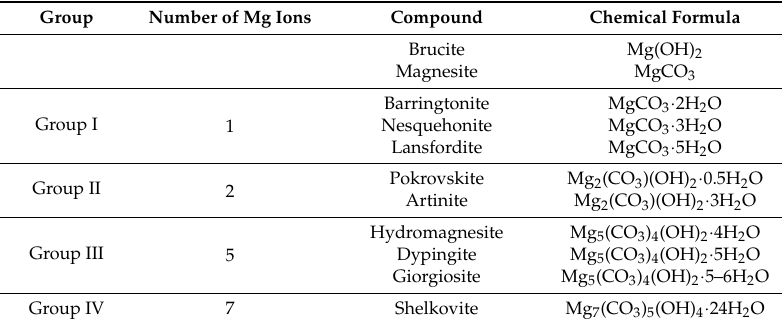
Table 1. Compounds formed in the MgO–CO 2 –H 2 O system